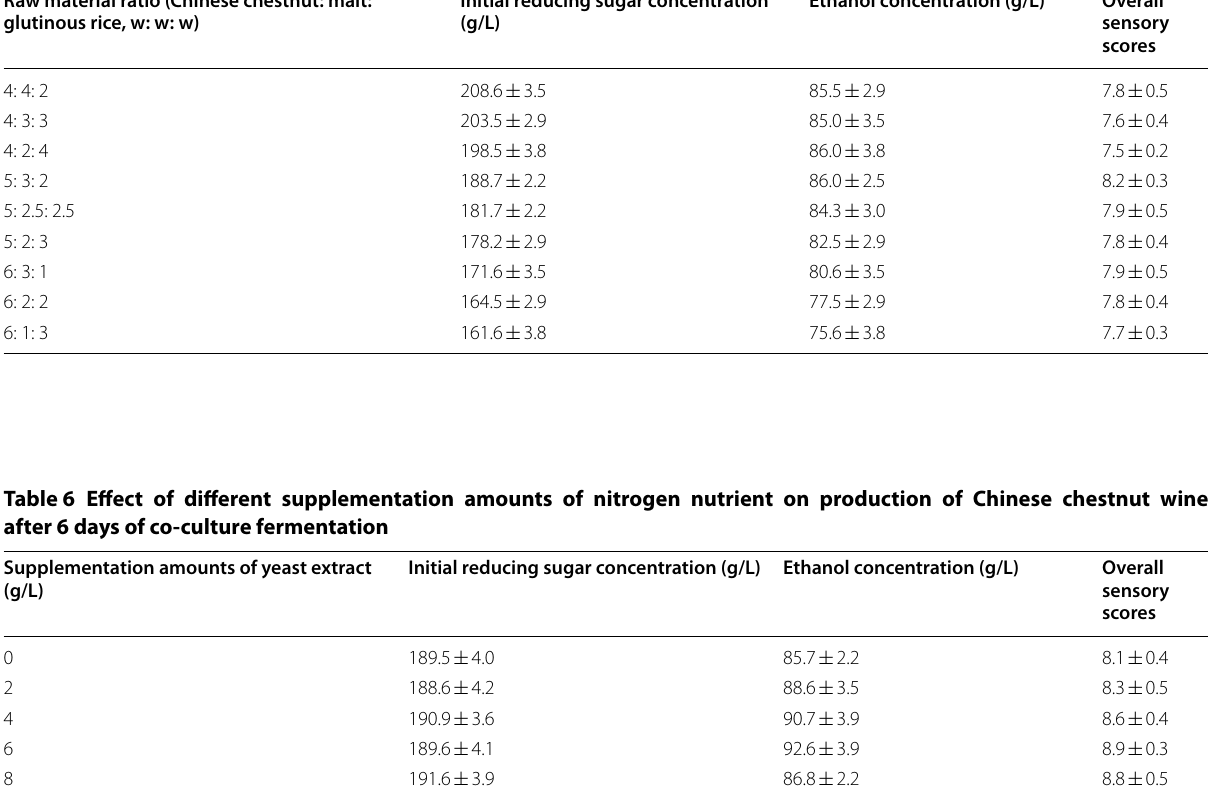
indicates standard derivation among replicates ±